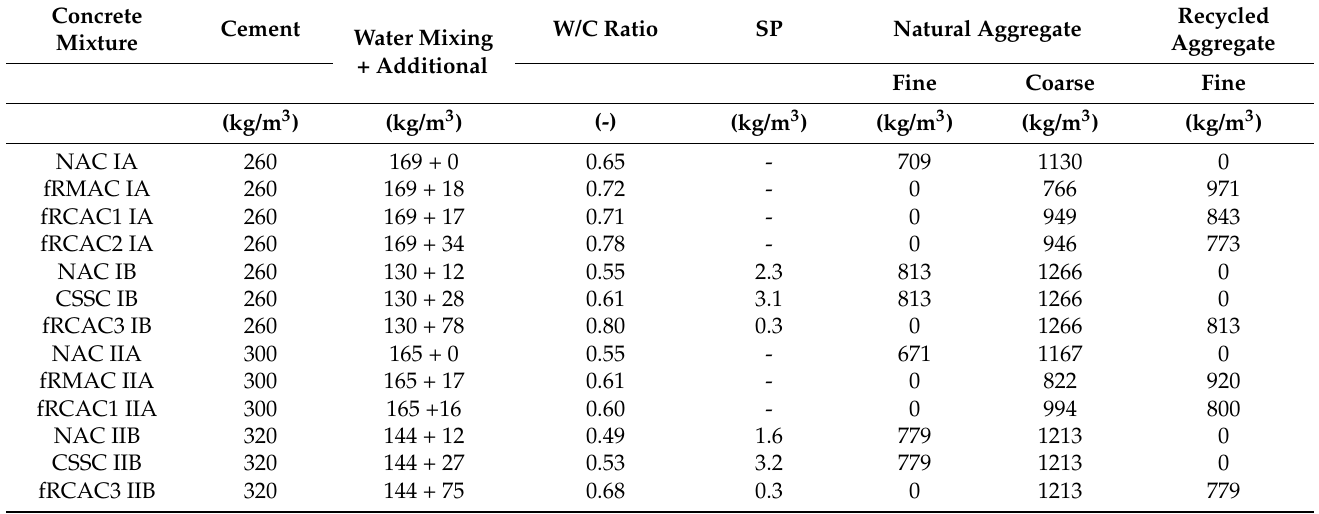
Table 3. Concrete mix proportion, per cubic meter.